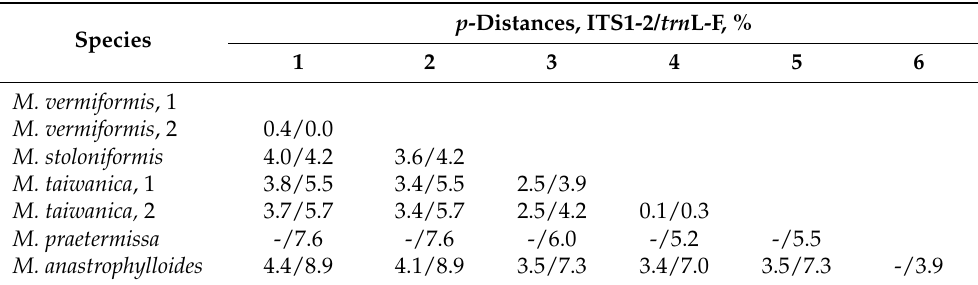
Table 1. The values of p -distances, calculated for specimens from the section Stolonicaulon based on ITS1-2 and trn L-F nucleotide sequence data. p -Distances, ITS1-2/ trn L-F, % Species 1 2 3 4 5